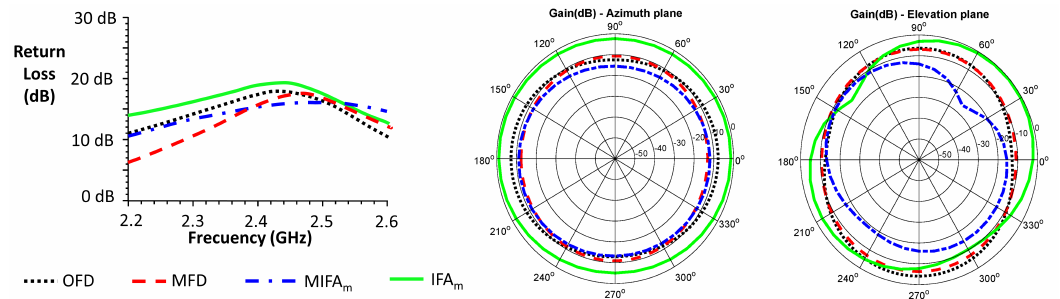
Figure 6. Simulated return losses and radiation pattern (azimuth and elevation planes) of the proposed